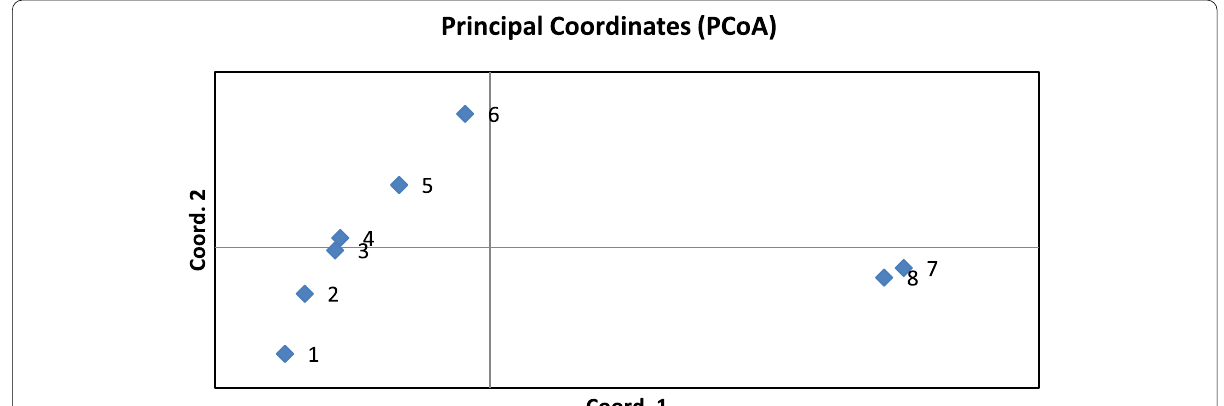
Fig. 3 PCoA analysis of the results of genotyping ryegrass cultivars using SCoT markers: 1 –Agat; 2 – Duet; 3 – VIK 66; 4 – Karat; 5 – Fenix; 6 – VIK 22; 7 – Rapid; 8 –Moskovsky